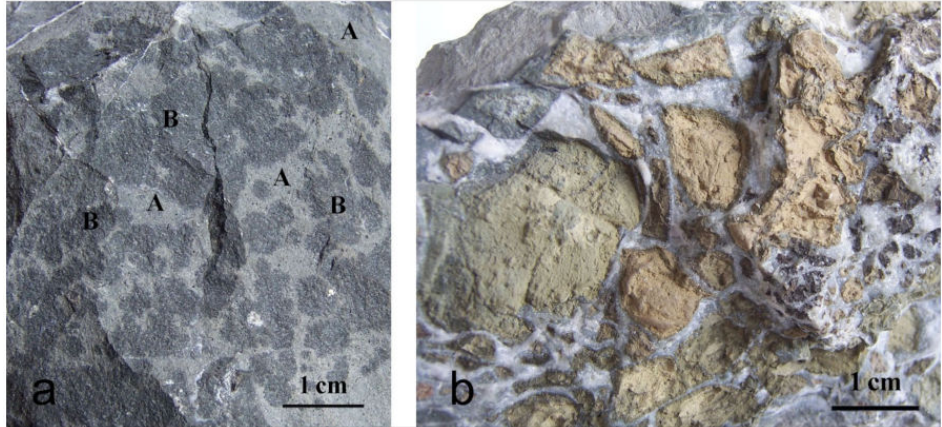
Figure 4. ( a ) Detail of a pillow core displaying a partly spilitized green-grey groundmass (A), with dark gray spots (B) of freshly preserved basalt. ( b ) Detail of hyaloclastite and pillow breccia with laumontite and other minor secondary